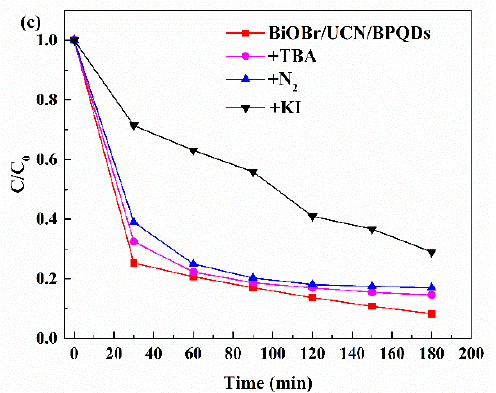
Figure 11. Electron paramagnetic resonance spectra of ( a ) superoxide free radical (·O 2− ) in dark and light and ( b ) hole (h + ) in dark and light. ( c ) Degradation effect after t-butanol (TBA), N 2 , and potassium iodide (KI) catalyst addition.